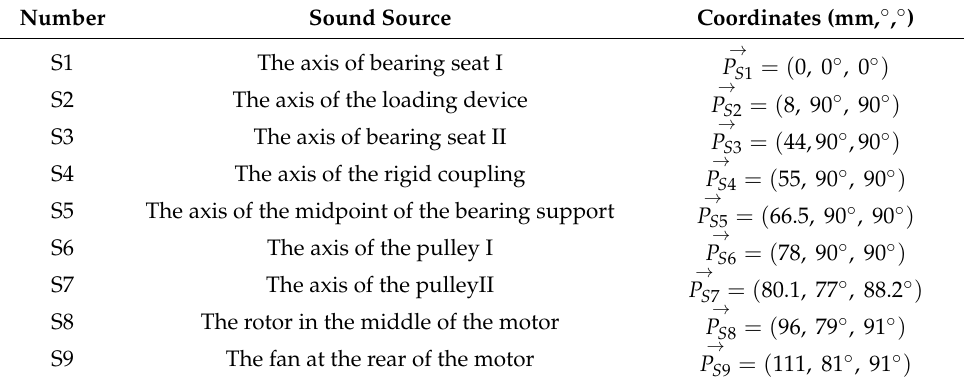
Figure 3. The nine sound sources on the test bench. Table 2. The locations of the nine sound sources.